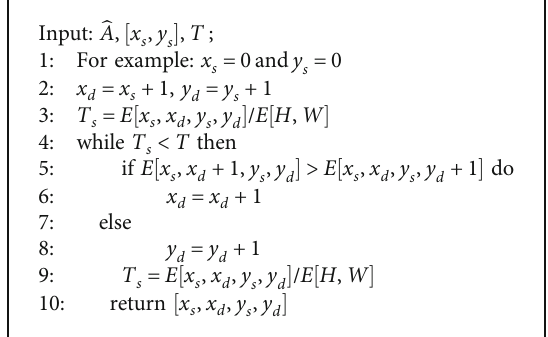
Algorithm 1: Single-object-based region